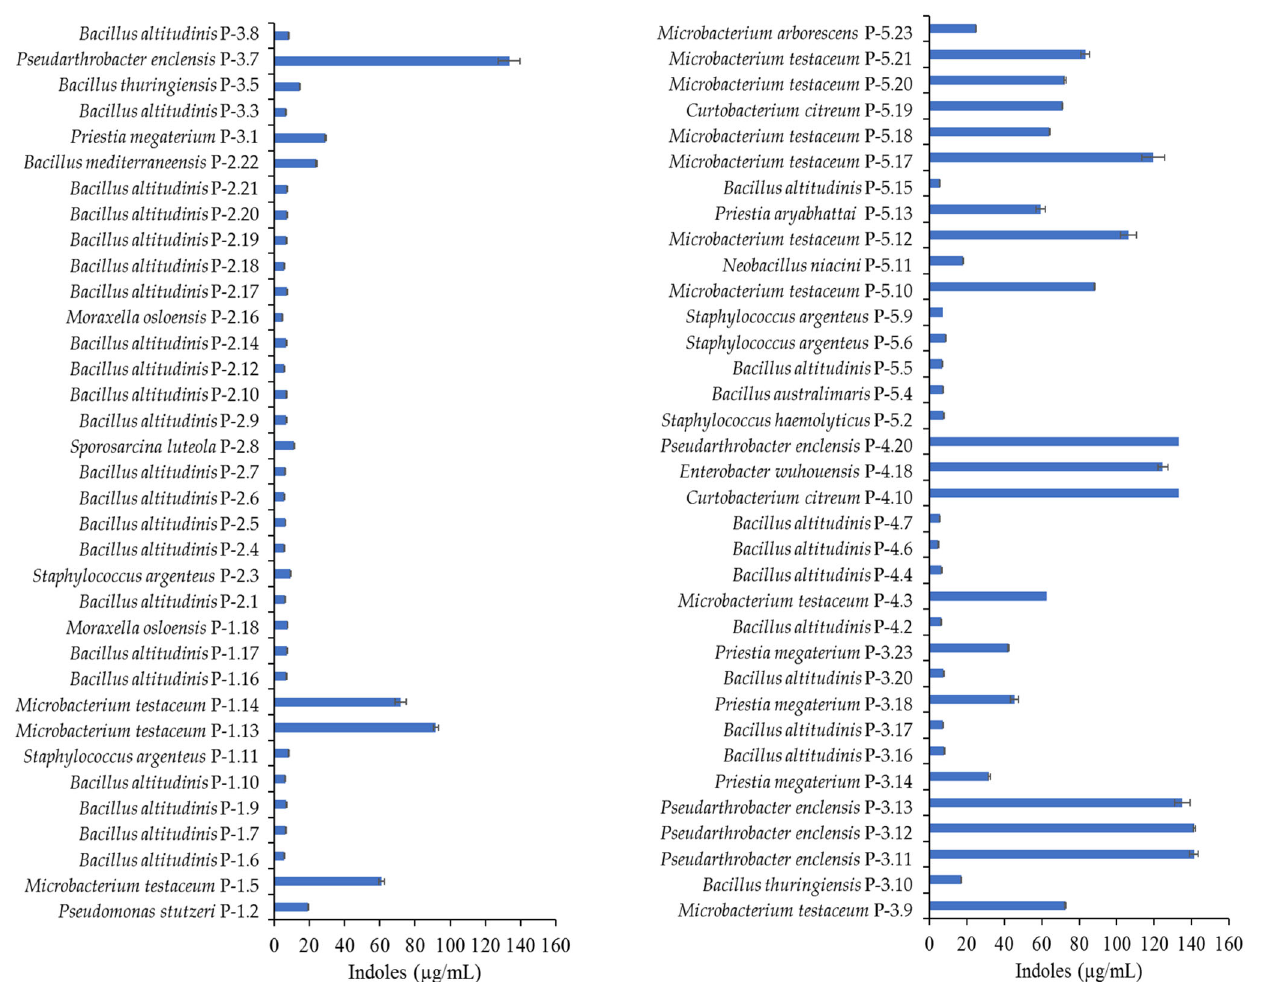
Figure 3. Indole ‐ related compounds production and accumulation of 70 bacterial endophytes from Figure 3. Indole-related compounds production and accumulation of 70 bacterial endophytes from tea leaves cultivated in nutrient broth supplemented with 1 mg/mL L ‐ tryptophan at 30 °C at 150 tea leaves cultivated in nutrient broth supplemented with 1 mg/mL L-tryptophan at 30 ◦ C at 150 rpm rpm for 72 h. for 72